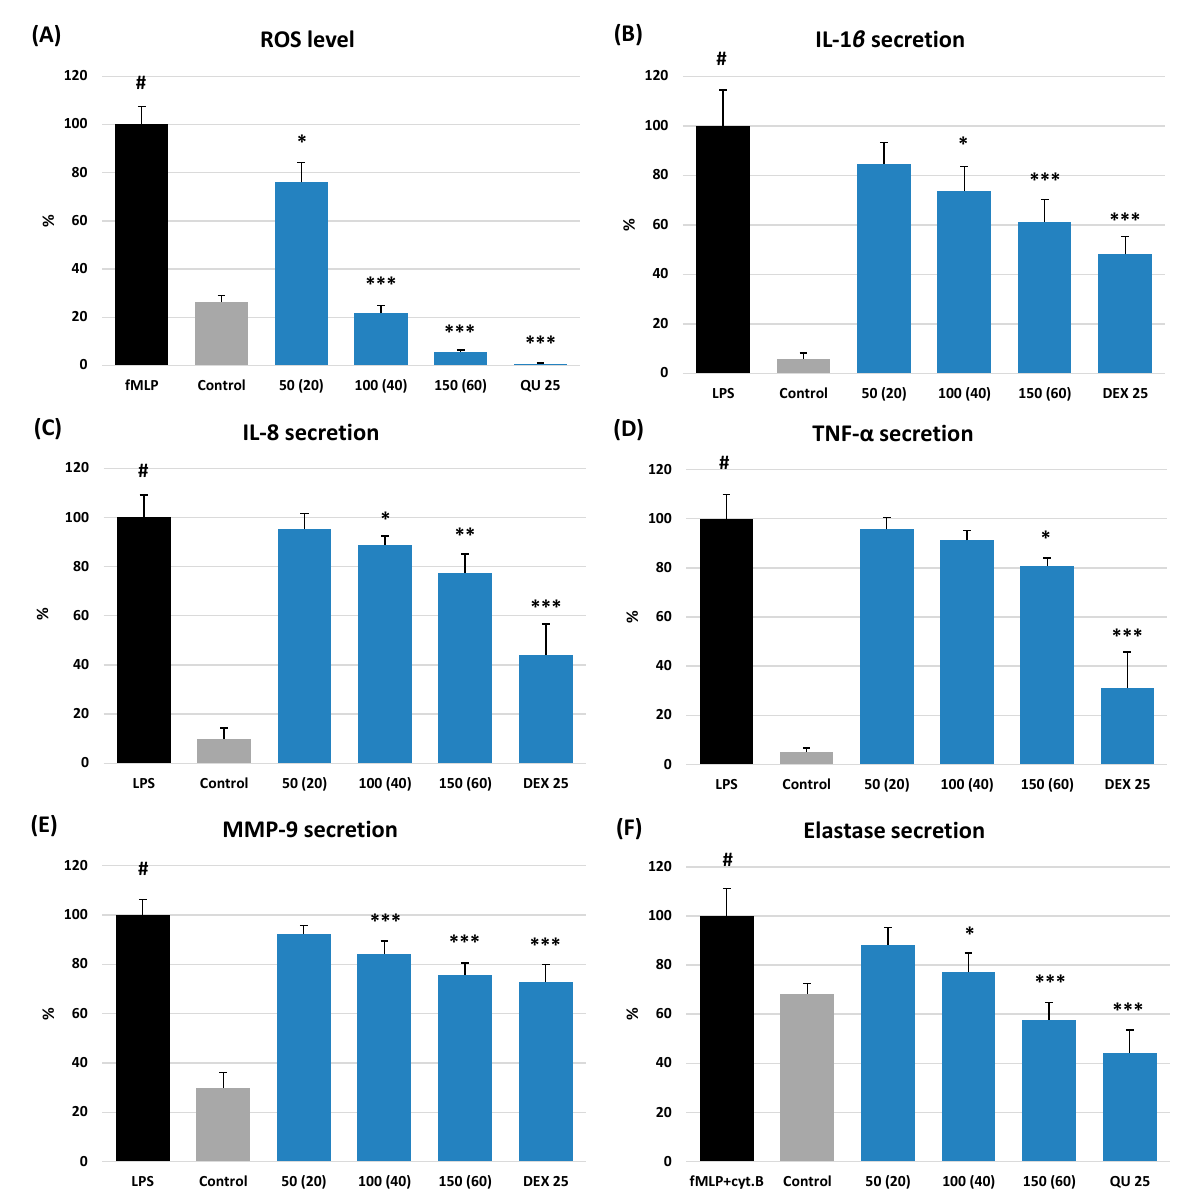
Figure 4. Effect of ME at 50–150 μ g/mL (20–60 μ g TPH + TPA/mL) on: ( A ) ROS level, and secretion of ( B ) IL-1 β , ( C ) IL-8, ( D ) TNF- α , ( E ) MMP-9, and ( F ) ELA-2 by stimulated human neutrophils. Data expressed as means ± SD of three independent experiments performed with cells isolated from five independent donors. Statistical significance: # p < 0.001 compared to the non-stimulated con- trol; * p < 0.05, ** p < 0.01, *** p < 0.001 decreased compared to the stimulated control. Positive con- trols tested at 25 μ M: quercetin (QU) and dexamethasone (DEX).